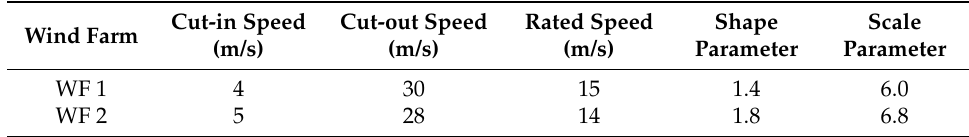
Figure 5. The EGH-IES sample. Table 1. Parameters of the wind